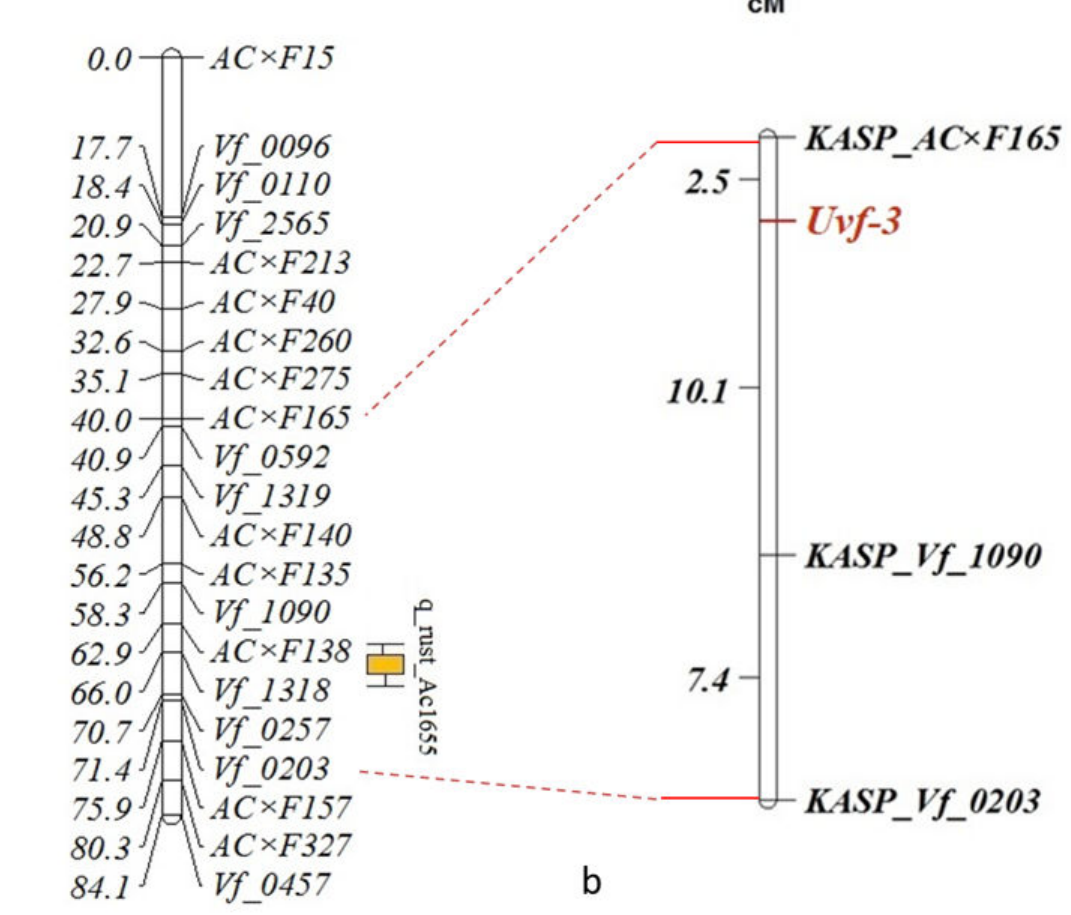
Figure 4. Linkage maps of chromosome V of the Fiord/Ac1655 RIL population: ( a ) location of QTL for rust resistance in 1536 Illumina and GBS-t based map and ( b ) association of KASP markers converted from SNP in the QTL region with Uvf-3